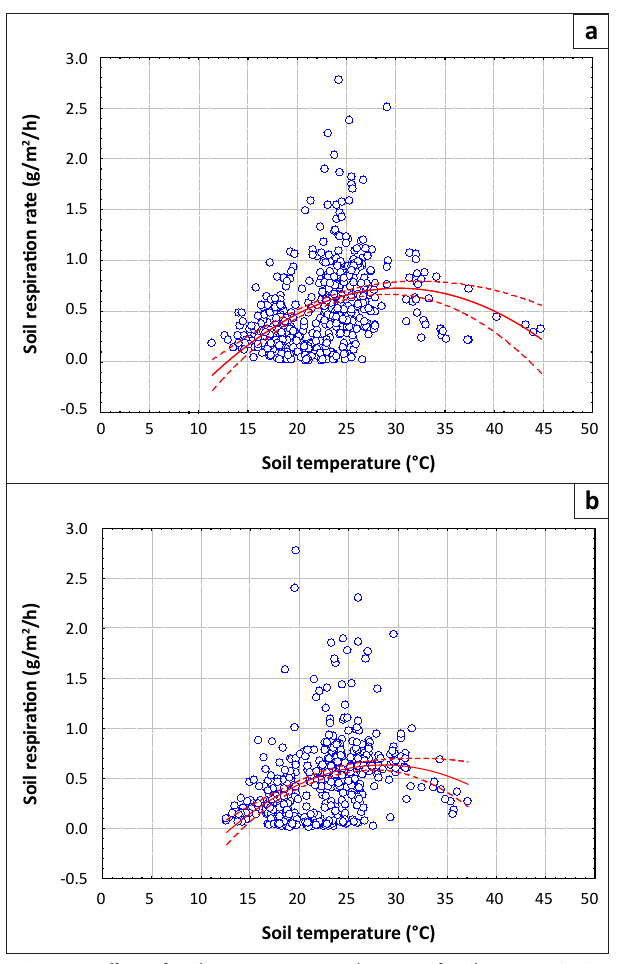
FIGURE 1: Effect of soil temperature on the rate of soil CO in the (a) Acacia savannas ( R 2 = 0.153) and (b) Combretum savannas ( R 2 = 0.154) . Maximum respiration peaks at about 28 o C and then declines. The dots are data and the solid line represents the fitted polynomial regression curve at 95 % confidence interval (dashed